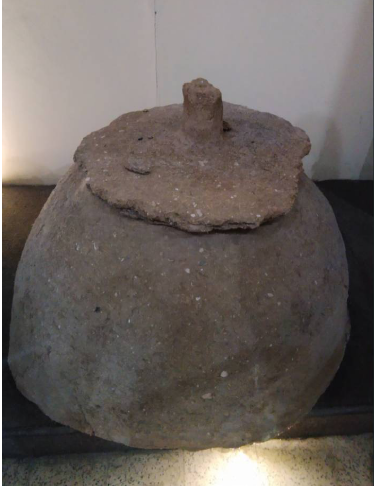
Figure 8. Dough discs pressed onto the inner walls of tannur for